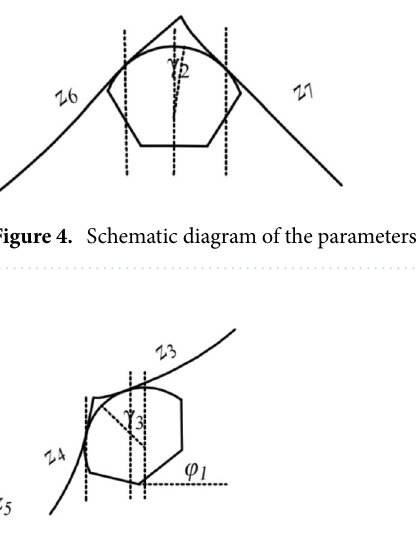
Figure 5. Schematic diagram of the parameters on the left splay saddle.